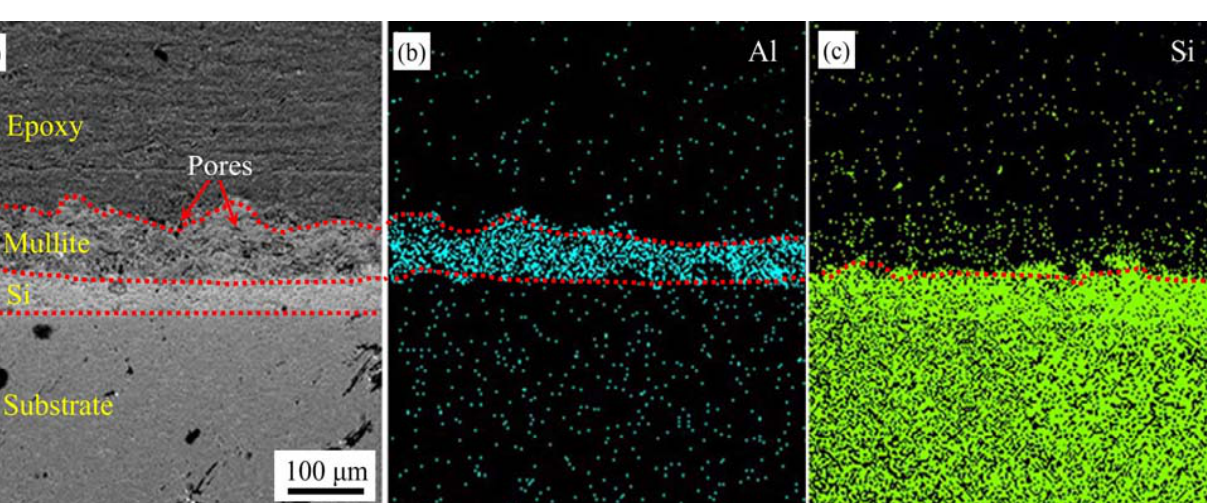
Figure 9. ( a ) Cross ‐ section of as ‐ sprayed EBC, ( b ) element distribution map of Al, and ( c ) element distribution map of Si.